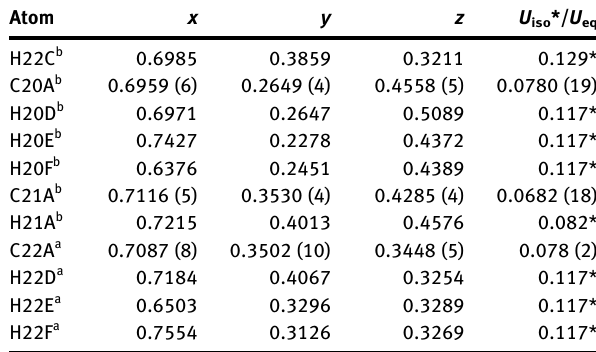
basic dinuclear complex consists of two Ti 4 + ions, two 2- oxido-2-phenylacetate (mandalate) ligands two esteri fi ed mandelate and two propan-2-olate groups (the fi gure).